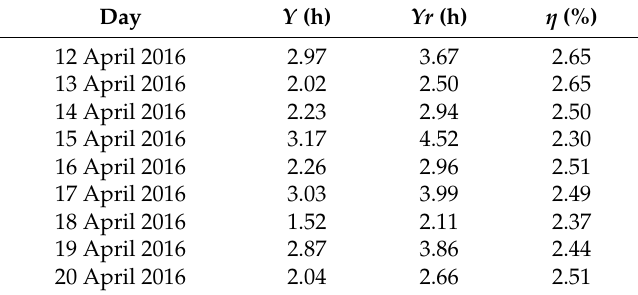
Table 3. DSM and reference daily yield, together with the daily efficiency during the period of